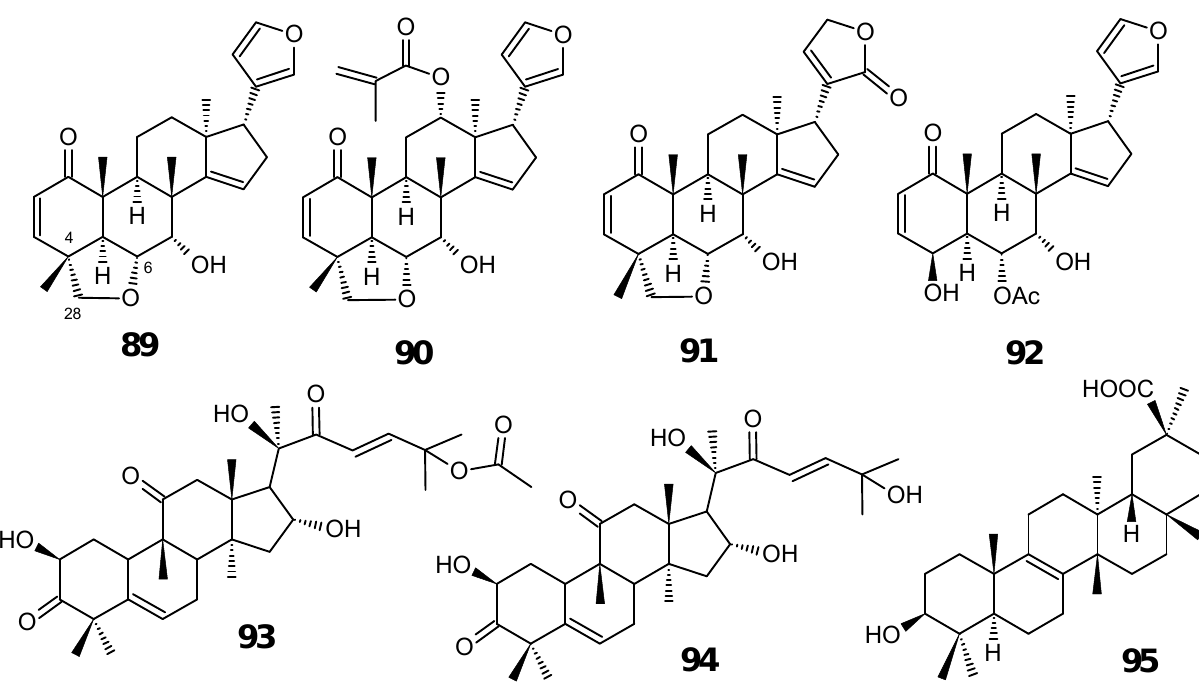
Figure 10. Antiplasmodial terpenes 89-95